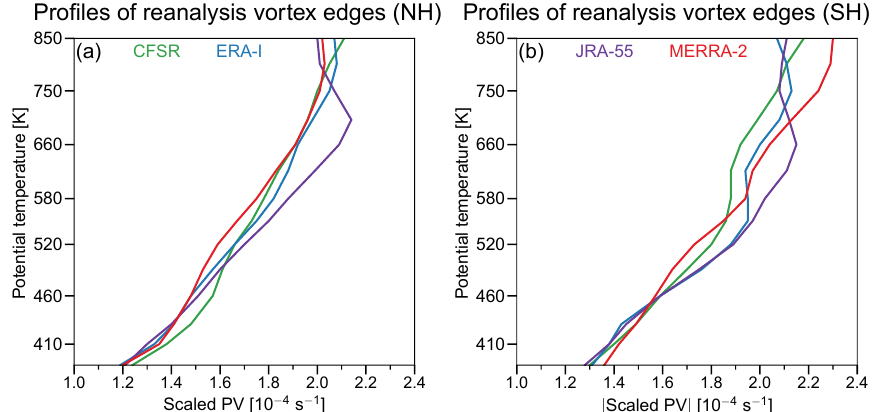
Figure 2. Potential temperature profiles of the reanalysis vortex edges determined from climatological maximum PV gradients expressed as scaled PV for the NH (a) and the SH (b) . Green, blue, purple, and red indicate CFSR/CFSv2, ERA-I, JRA-55, and MERRA-2,